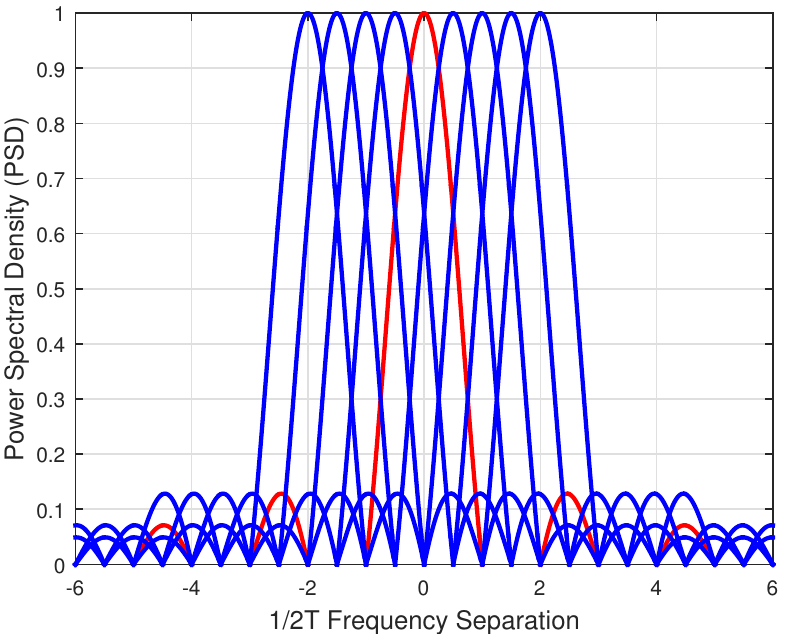
Figure 2. Spectrum of an OFDM signal with N subcarriers. Subcarriers of M -ary ASK-OFDM with spacing of 1/2 T